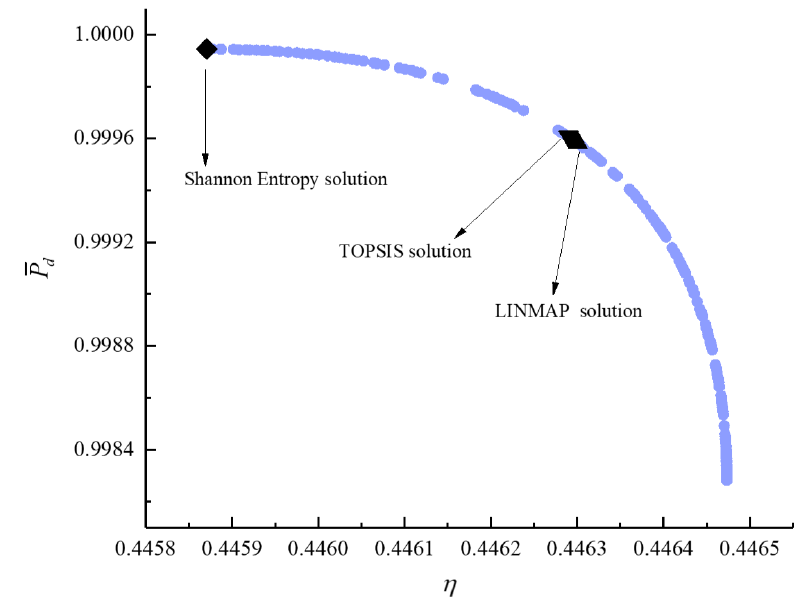
Figure 19. Bi-objective optimization on η − P d .